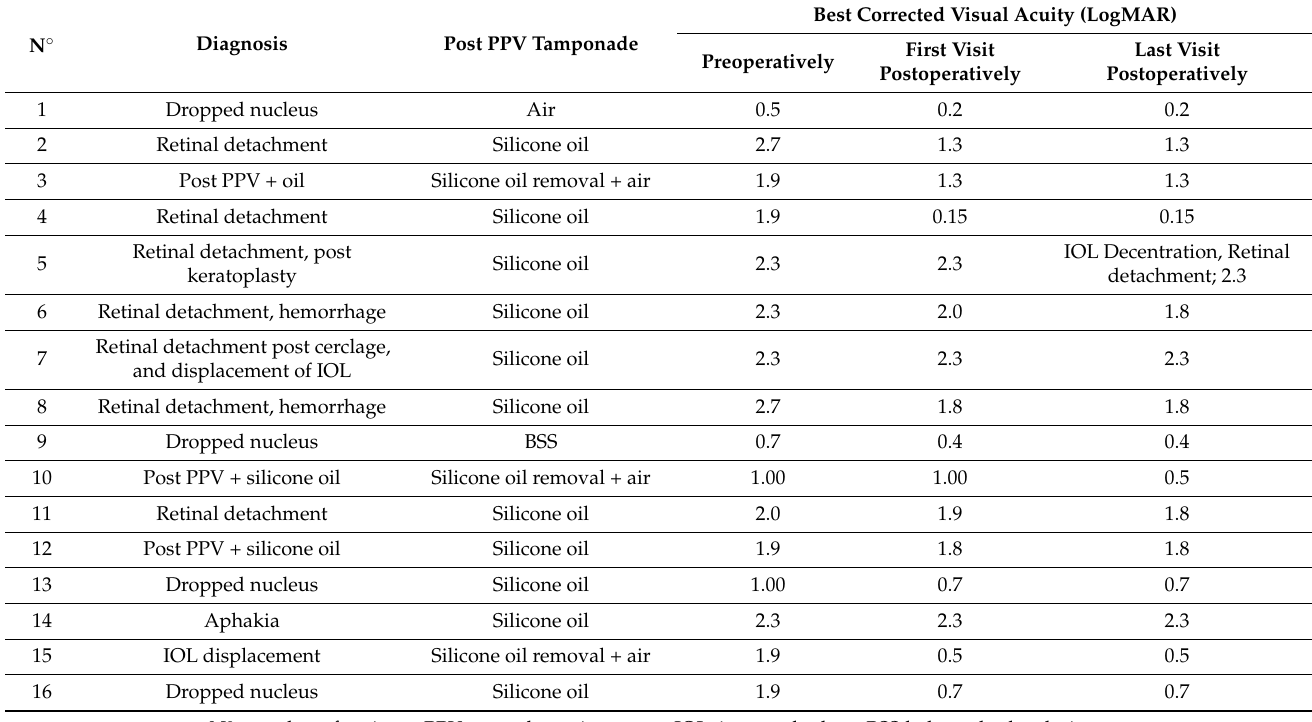
Table 2. Preoperative and postoperative visual outcomes in eyes with posttraumatic aphakia treated with the Yamane technique followed by pars plana vitrectomy (PPV) (Group B).